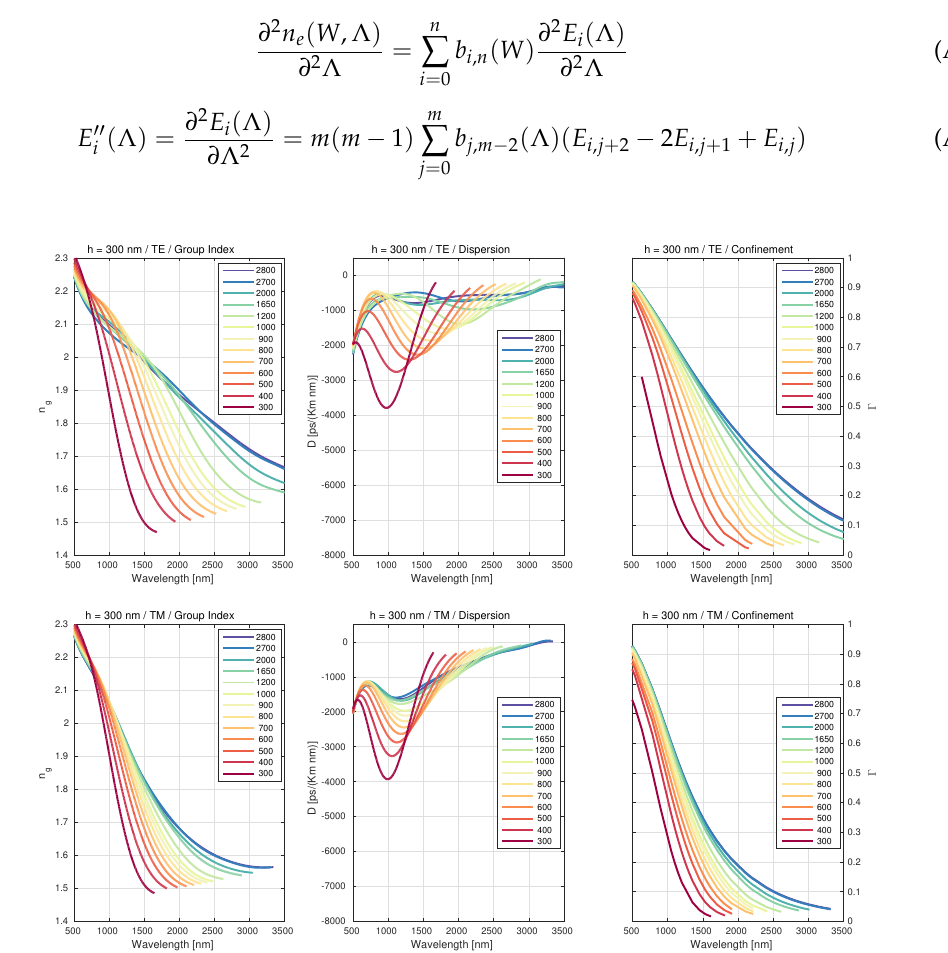
Figure A1. Linear propagation properties: group index, dispersion and confinement, vs. wavelength, for different waveguide